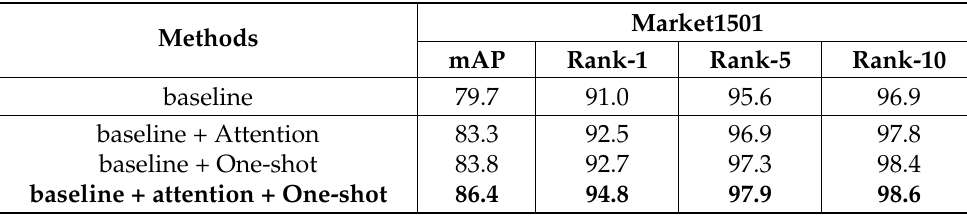
Table 5. Ablation study of our proposed framework on individual